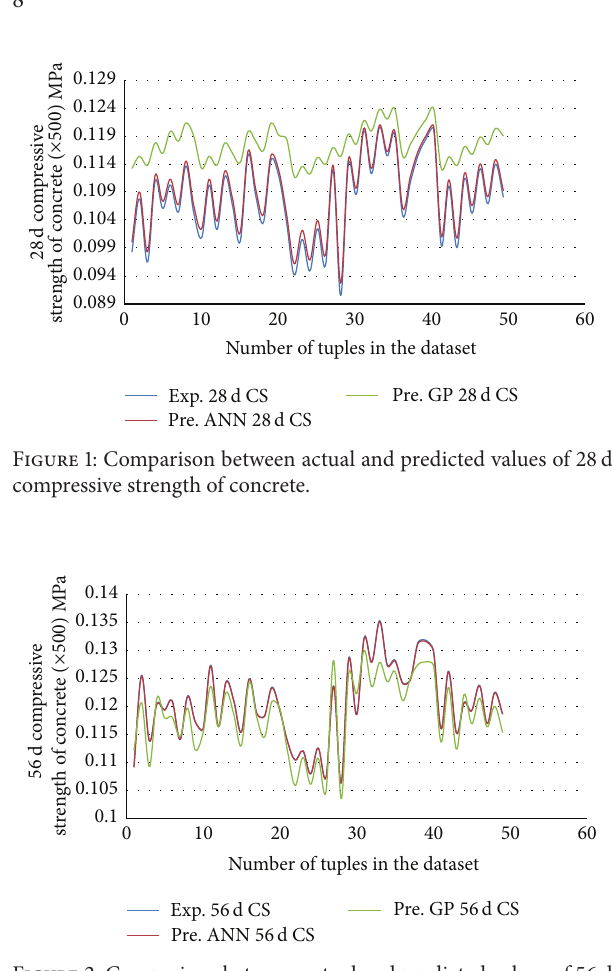
Figure 2: Comparison between actual and predicted values of 56 d compressive strength of concrete.